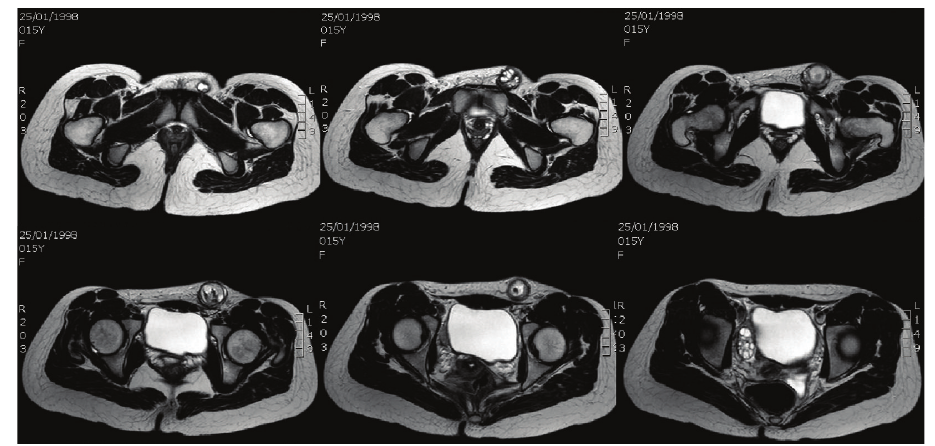
Figure 2: MRI study revealing the ovarian mass herniated in the inguinal region, transverse section.